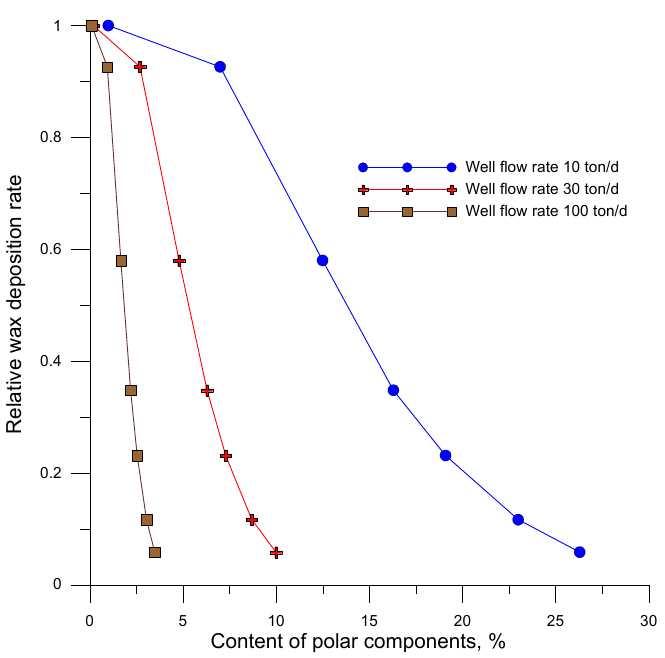
Figure 2. Influence of the content of the polar component in oil on the relative wax deposition rate, μ (cid:2925) = 10 mPa ∙ s, C (cid:2925) = 0.0546 .